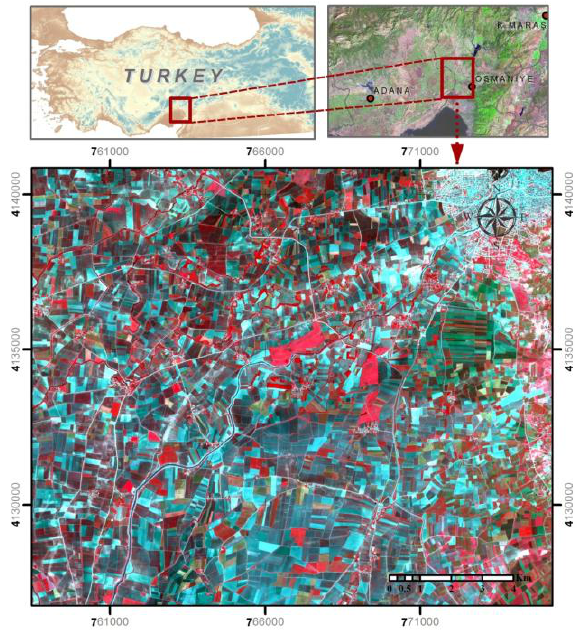
Figure 1. Study area including Kadirli, Ceyhan and Osmaniye in